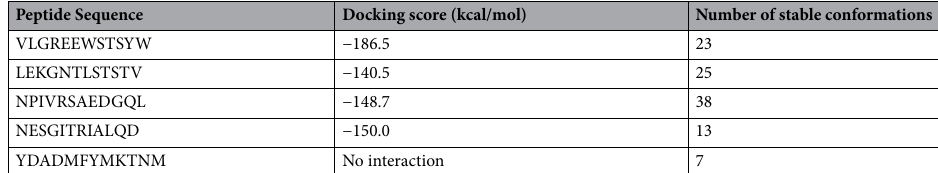
Peptide Sequence Docking score (kcal/mol) Number of stable